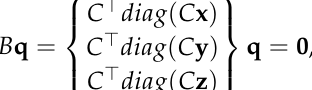
structures are numbered from level 1 to level 10. In the ten-level tensegrity model, totally 60 AFBs and 30 MTs are modelled as the cytoskeletal components. The free nodes surfaces are distributed in the intracellular space at different heights in the model. In this model, the odd numbered levels of the structure are in the left-handed form, while the even numbered levels are in the right-handed form. As a result, the potential rotational displacement would be countered within the adjacent levels of the tensegrity structure during the central indentation, and the cell can still approximately behave as an axis-symmetric entity during deformation. In the proposed ten-level tensegrity model of a HEK-293 cell, the lengths of the AFBs and MTs in each level are listed in Table